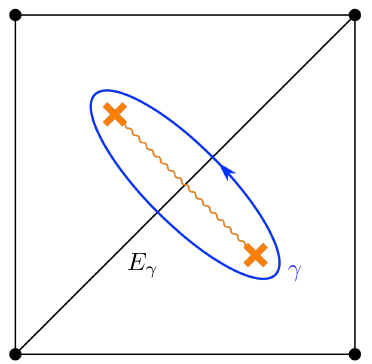
Figure 1 . To each edge of T ϑ we can assign a cycle γ on the Seiberg-Witten curve Σ , and denote the corresponding edge by E γ . Punctures are indicated by solid circles and branch points by orange crosses. The orange wavy line represents a choice of branch